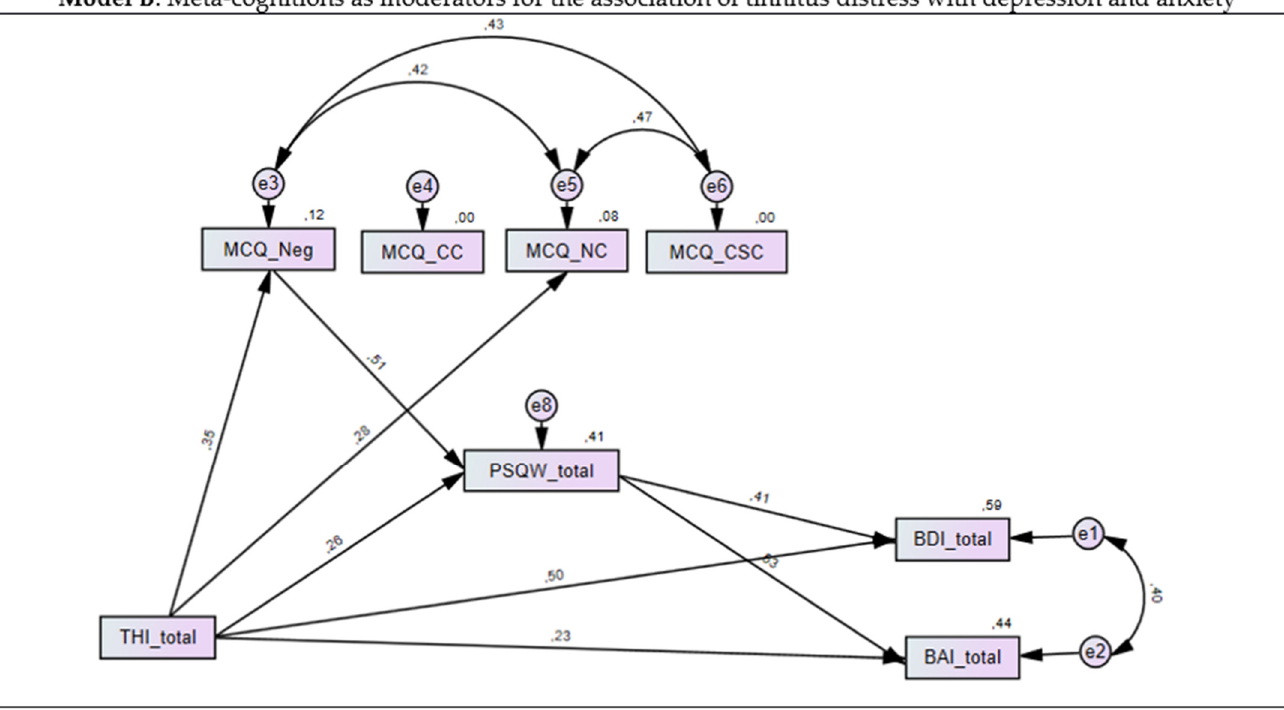
Figure 3. Structural equation model (SEM) for the moderated influence of tinnitus distress on depression and anxiety. Worries were added to the model as moderators for the two dependent variables and meta-cognitions as predictors for worries. Pos = positive beliefs about worry; neg = negative beliefs about the controllability of thoughts and danger of worry; CC = cognitive confidence; NC = beliefs about the need to control thoughts; CSC = cognitive self-consciousness. Rectangles represent variables and circles represent error terms (e). Numbers next to arrows in the model represent statistically significant standardized estimates, numbers next to factors represent the R 2 , i.e., the explained variance.